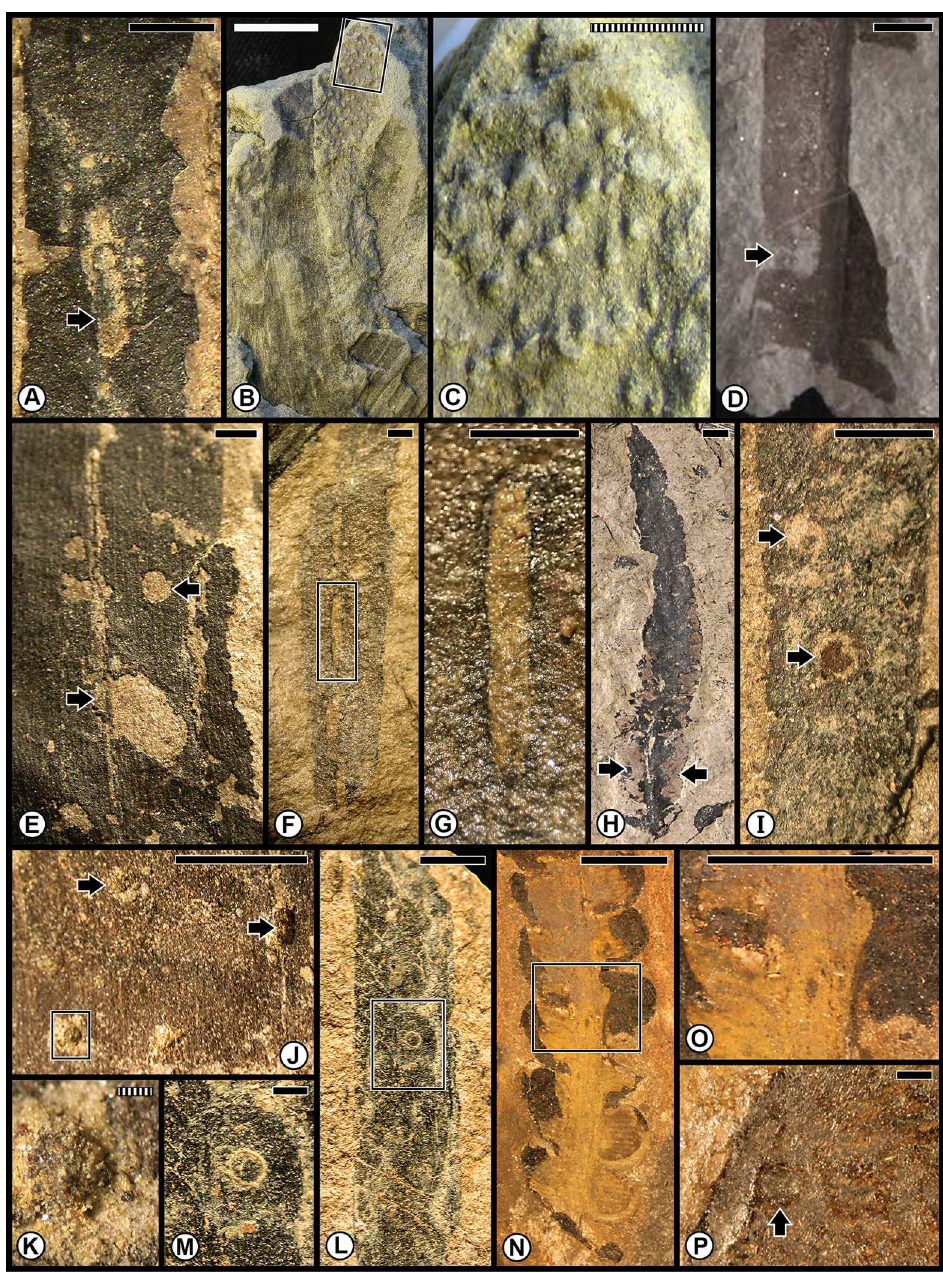
Fig 6. Plant–insect interactions from the Middle Triassic (Anisian) Ku¨hwiesenkopf/Monte Pr à della Vacca Flora, of the Dont Formation at Ku¨hwiesenkopf/Monte Pr à della Vacca in the northeastern Dolomites. A : The lycopod Lycopia dezancheri , showingan example of slot feeding(DT08). SpecimenPAL- 7603. B : A stem of the sphenopsid Neocalamites asperrimus , with a cluster of oviposition scars (DT159). Specimen PAL-11. C : Enlargement of a series of linear rows of oviposition scars in (B). D : Incised margin feeding(DT15) on an isolated pinnuleof the cycadophyte Bjuvia sp., indicatedby black arrow. Specimen PAL-1599. E : A leaf of the cycadophyte Bjuvia sp. with examplesof hole feeding (DT01, DT02), indicated by arrows. Specimen PAL-294. F : The cycadophyte Bjuvia dolomitica , showingfour examples of slot feeding (DT08). Specimen PAL-2147. G : Enlargement of slot feeding (DT08) indicatedby rectangular template in (F), showingunderlying matrix. H : Surface feeding(DT82) on both sides on the basal portion on a cycadophyte leaf of Bjuvia sp. Specimen PAL-729. I : Two minisculegalls (DT80), indicatedby black arrows on the cycadophyte Bjuvia sp. SpecimenPAL-655. J : Successive pinnules of the cycadophyte Bjuvia sp., showingseveral small galls (DT80). K : Enlargement of gall at the lower-left template in (J). L :